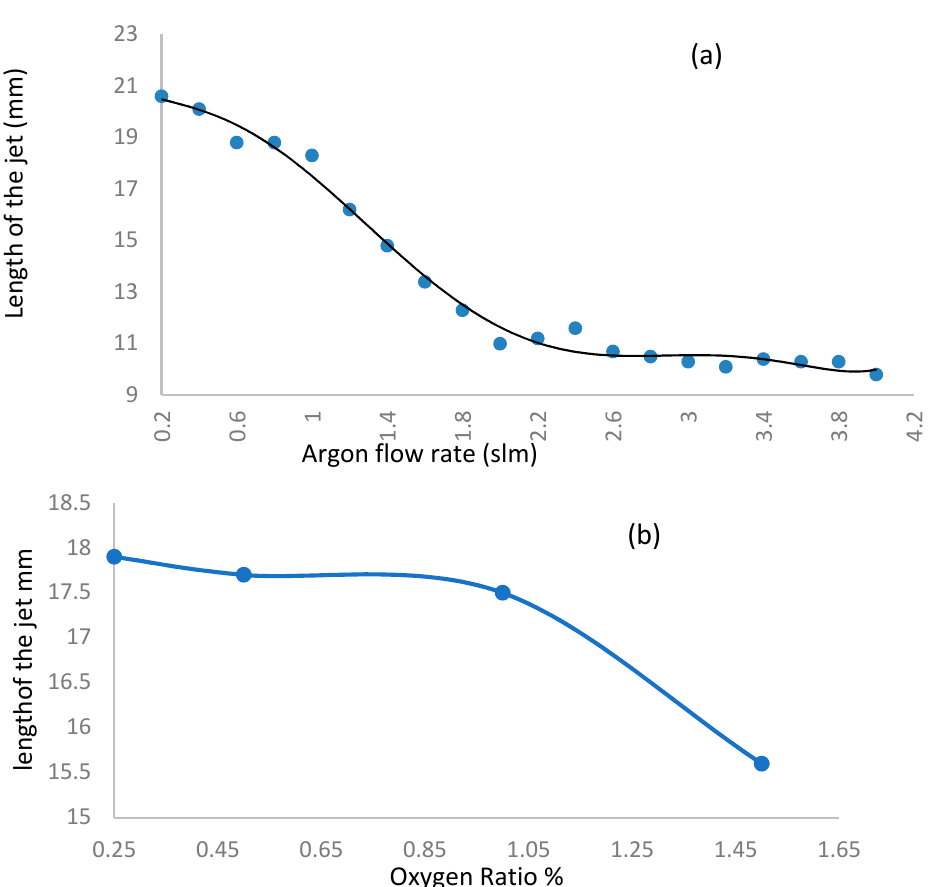
Figure 4. ( a ) Photo-imaging of the plasma jet lengths for argon discharge as a function of flow rate from 0.2 slm to 4 slm, and ( b ) Photo-imaging of the plasma jet lengths for oxygen ratio from 0.25% to 1.5%.